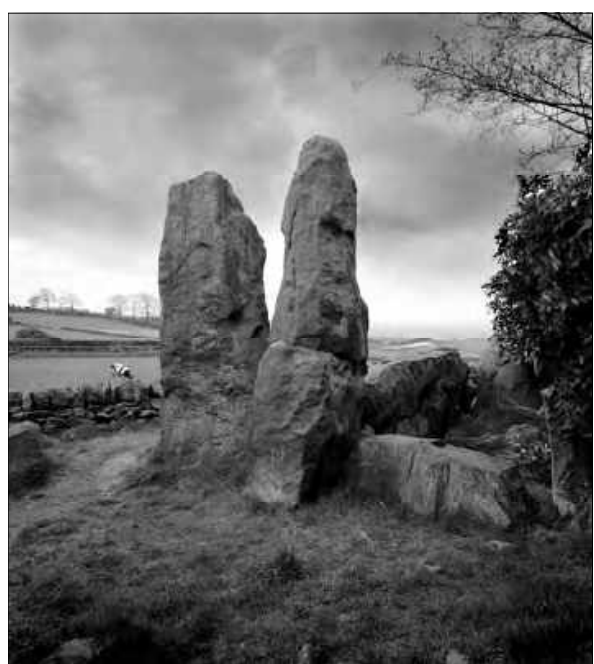
Fig 2.17 The megalithic burial monument the Bridestones, Cheshire (Cheshire County Council).